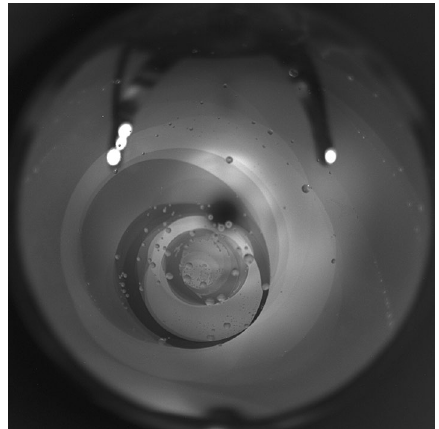
Figure 1. Smectic film in the form of a spherical bubble viewed in reflected white light. Regions of the film with different thickness have different brightness. Regions close to the center of the image have larger thickness than the outer regions. The bubble is heated close to the temperature of the Sm A ‒ Iso phase transition. Large droplets of the isotropic phase are visible in this image; small droplets can be seen in the micro images (Figs. 2, 5). The diameter of the bubble is about 1.5